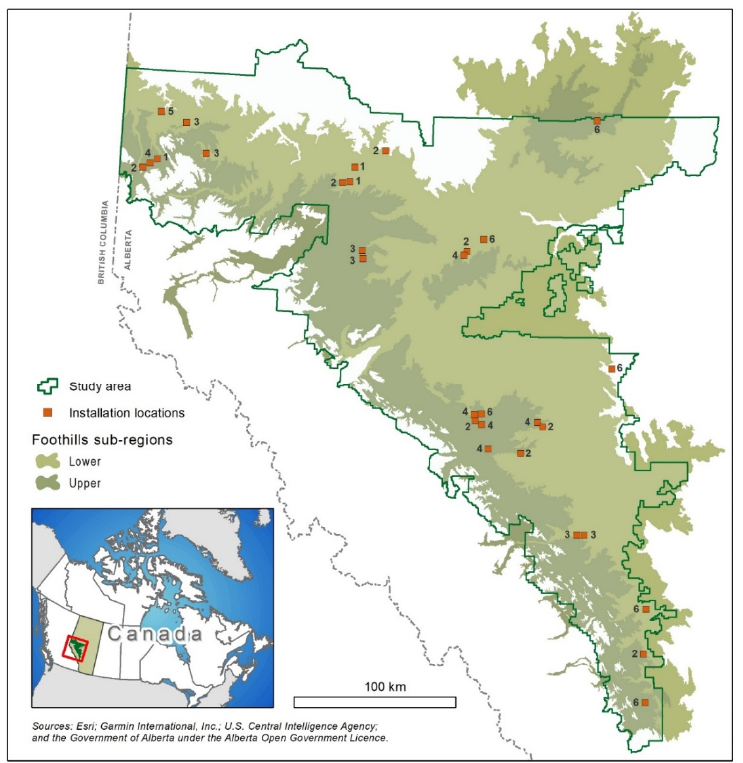
Figure 1. Locations of trial installations. The map shows the number of installations at each location. There are 102 installations in total (17 replications of 6 planting